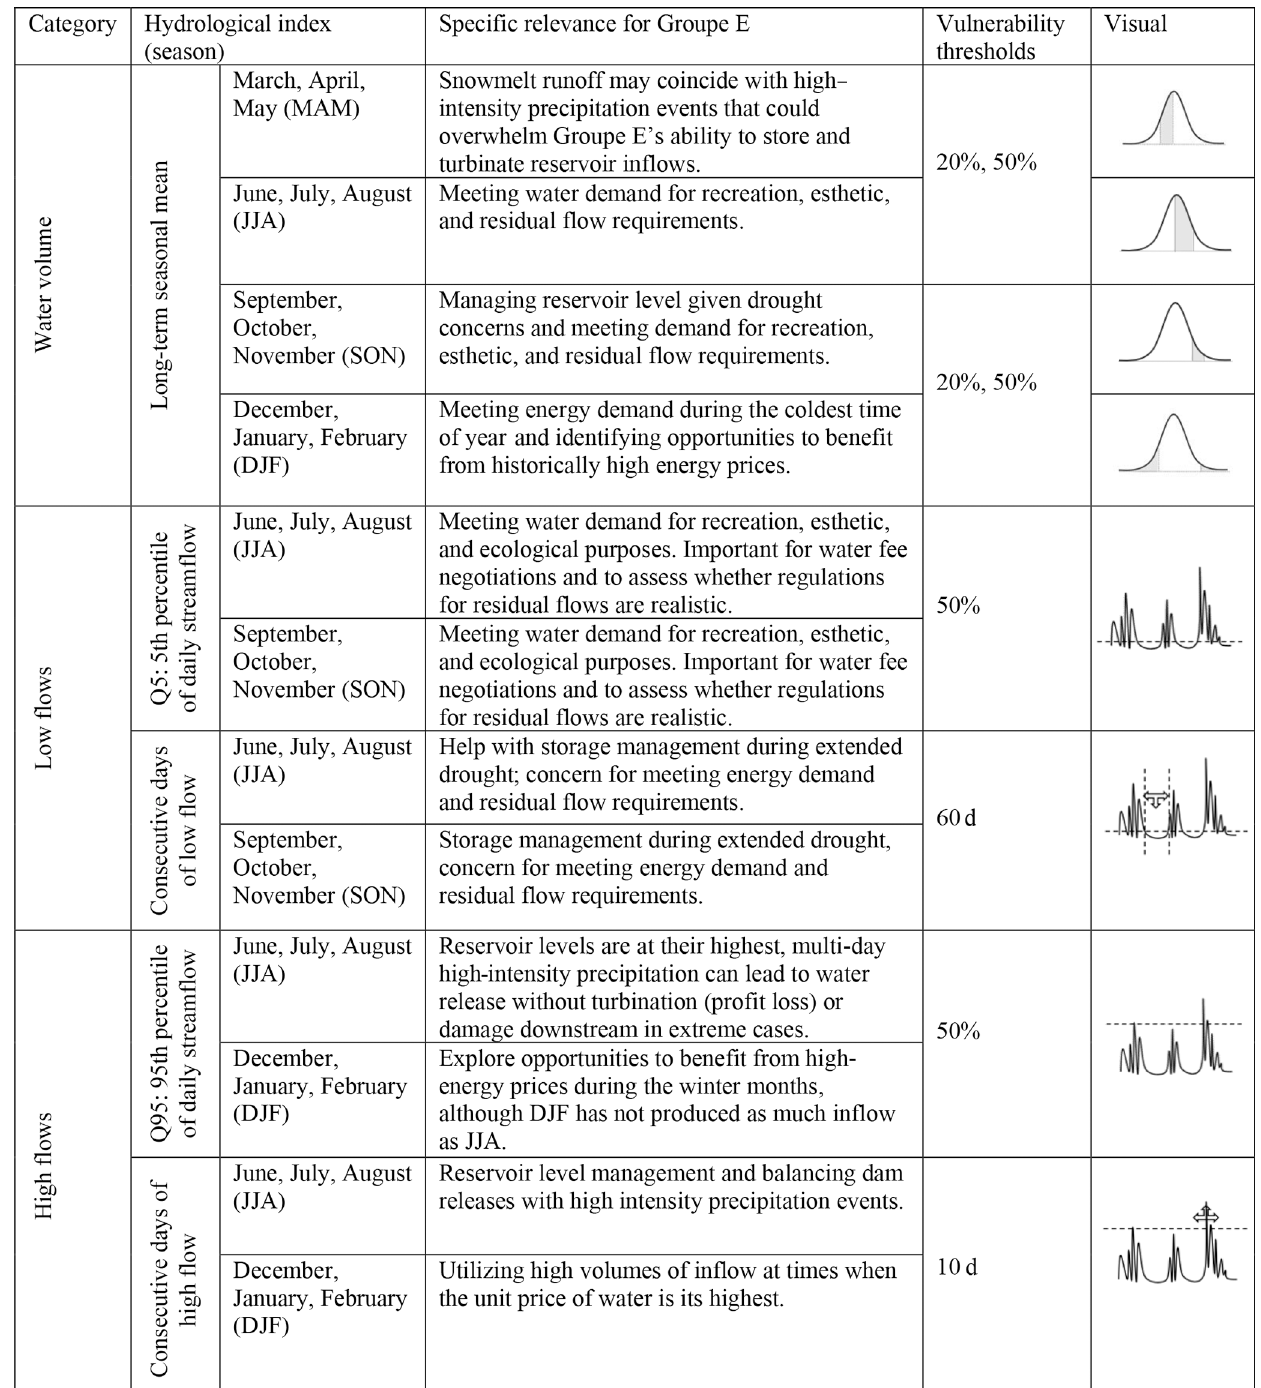
Table 2. Hydrological indices selected after discussions with Groupe E representatives. The relevance of each index for Groupe E’s oper- ations is explained, and the vulnerability thresholds for each index are provided. Relative changes exceeding these thresholds would have a significant impact on Groupe E’s operations. In cases where two thresholds are provided, the exceedance of the lower threshold represents a significant impact and the upper threshold represents a critical impact. Visual aids for each index are also provided in the far-right